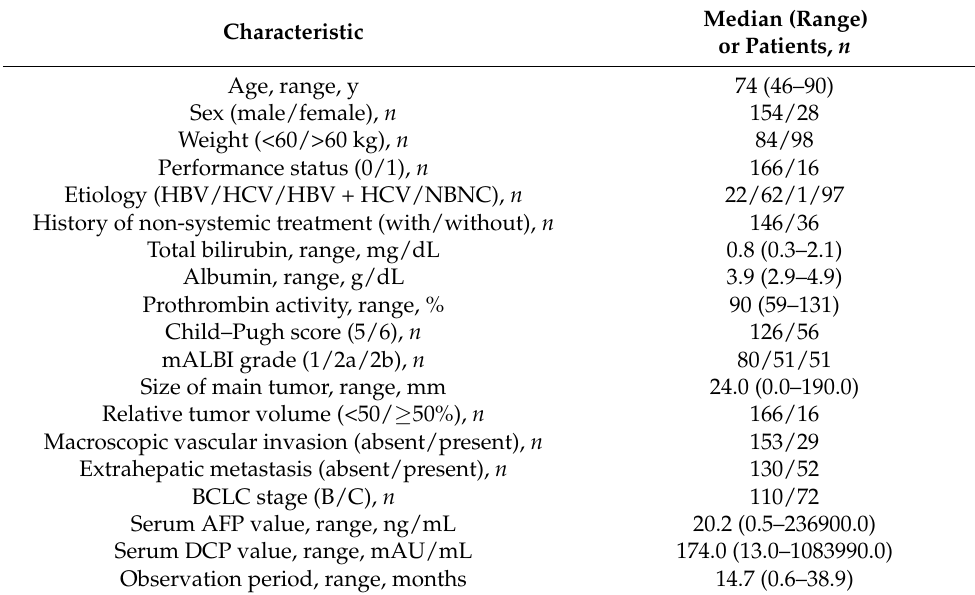
Table 1. Clinical characteristics at the initiation of lenvatinib ( n = 182).